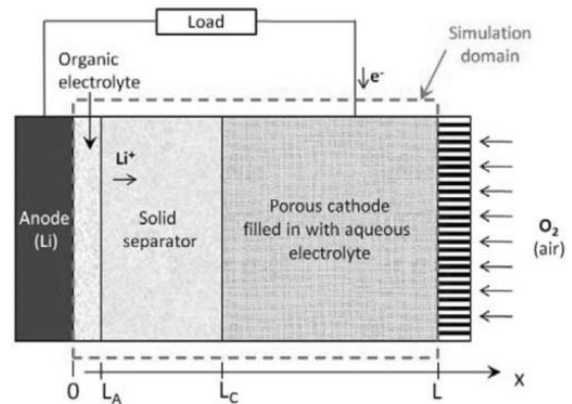
Figure 20. Li-air battery with aqueous electrolyte at the cathode and organic electrolyte at the anode, showing the region that is discretized and simulated. Ion and electron flows during discharge are shown by arrows. Republished from Andrei et al. [28] with permission of The Electrochemical Society conveyed through Copyright Clearance Center, Inc.